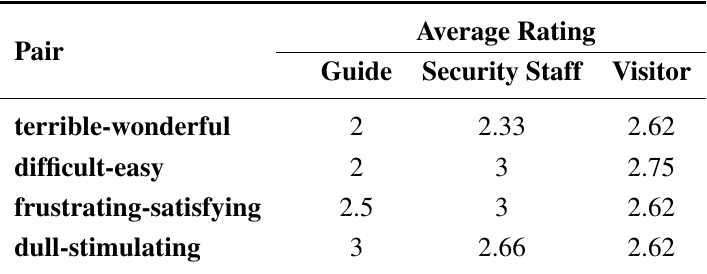
Table 4. Results for the fourth part of the questionnaire about the